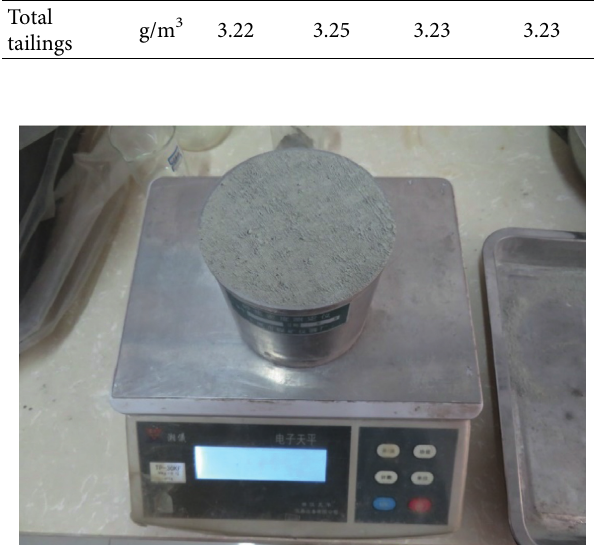
Figure 2: Bulk density determination